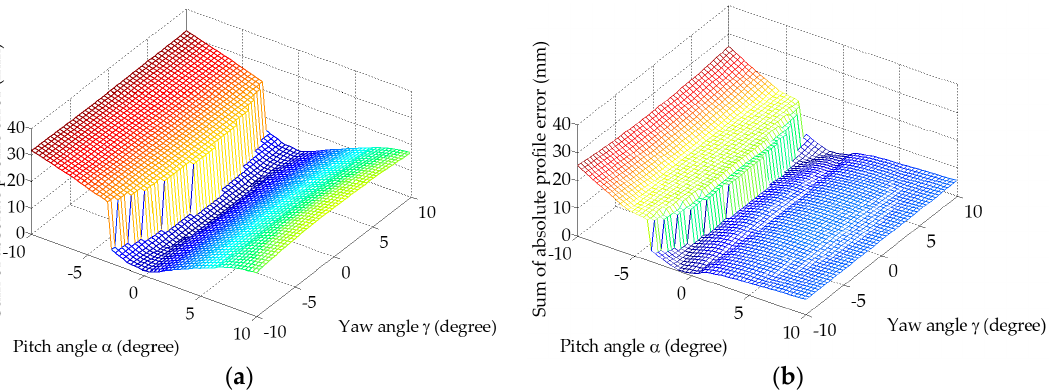
Figure 7. Solution spaces of the optimization to find the yaw and pitch angles: ( a ) Results for the left half of the gear profile with LTS 1; and ( b ) Results for the right half with LTS 2. Note each mesh contains 3000 vertices, a vertex in the plot represents the result of one iteration.